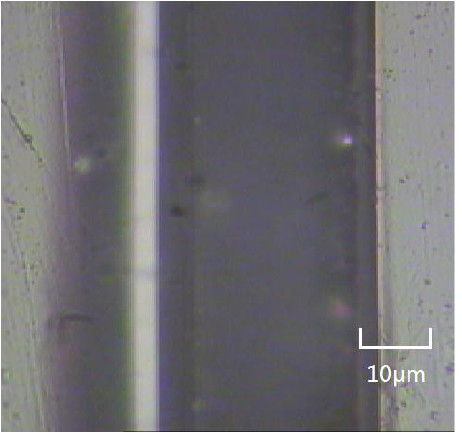
Figure 12. A 30 μm width rectangle